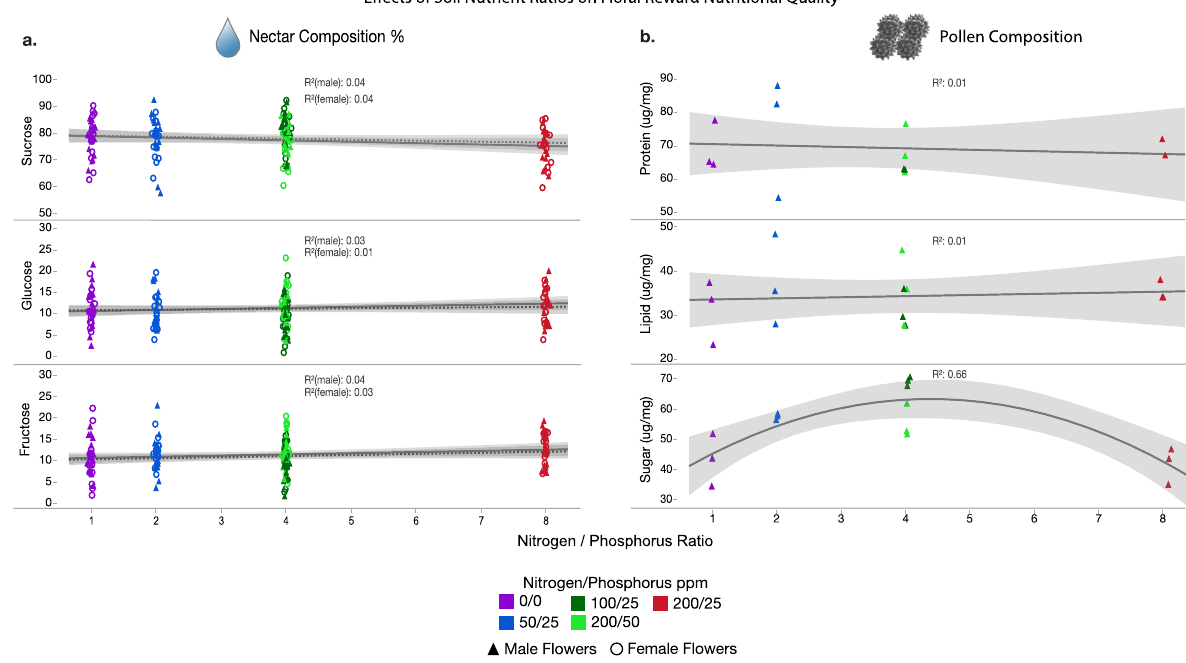
Figure 2. The effects of nitrogen:phosphorus soil nutrient ratios on floral reward composition (Supplementary Table S3). Regression lines are fitted with the quadratic nutrient ratio terms. For nectar, each marker represents a different individual plant. For pollen, each marker represents a pooled replicate. Each marker is colored by their treatment group and shaped by male or female flowers. Nitrogen ppm/phosphorus ppm of nutrient solutions for each treatment group are labeled in the legend. Note that changes in soil nutrient ratios did not affect male or female nectar sugar composition, nor pollen protein concentrations, lipid concentrations, or P:L ratios. Note that pollen sugar concentrations improved as ratios increased to 4:1, yet decreased at 8:1 (pollen sugar concentrations had no effect on bee visitation rates). The effects of nitrogen and phosphorus individually are provided in Supplementary Table